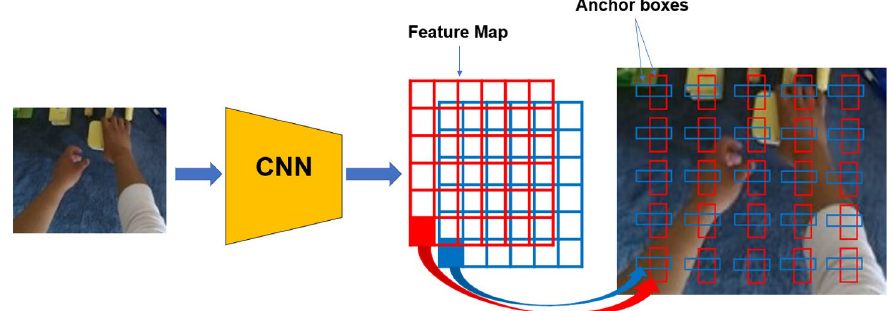
Figure 5. Anchor-based object